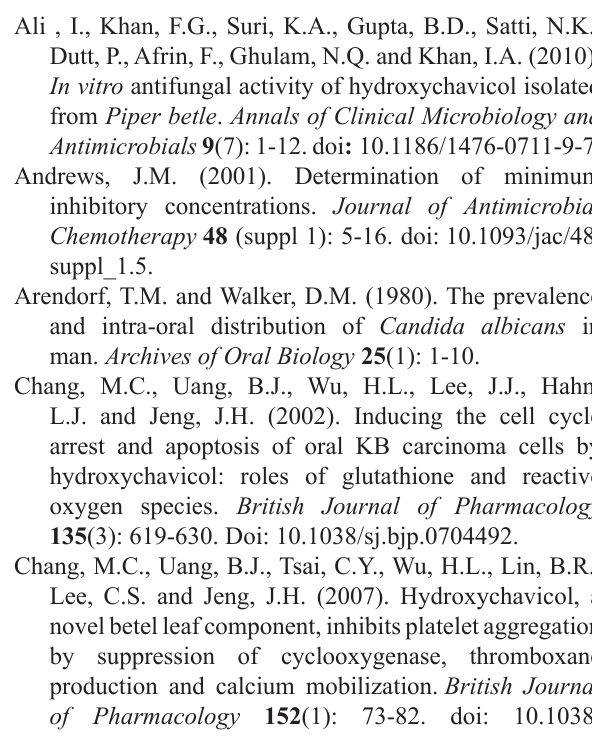
Table 3: Mean C. albicans (standard isolate + seven laboratory isolates) cell adhesion to denture acrylic surface with exposure to P. betle leaf ethanol extract (8,000 ppm), commercial denture cleanser (COM) and sterile distilled water (SDW). Solution Mean adhesion of no. of cells 8,000 ppm 0.387±0.18 b COM SDW 23.750±5.33 a Means denoted by the same letters within the column are not significantly different at P < 0.05.